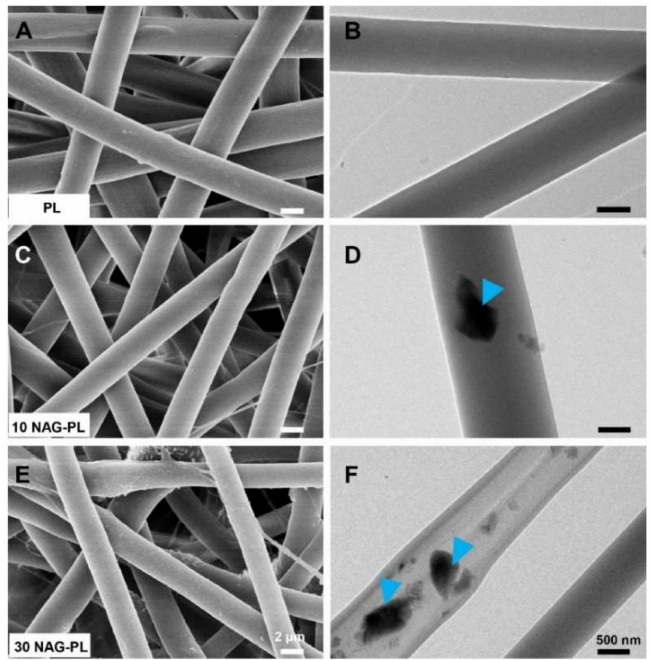
Figure 5. SEM ( A , C , E ) and TEM ( B , D , F ) images of the composite electrospun sca ff olds with di ff erent contents of NAG bioceramic particles: ( A , B ) pure polymer (PL); ( C , D ) polymer with 10% NAG bioceramic particles (10 NAG-PL); ( E , F ) polymer with 30% NAG bioceramic particles (30